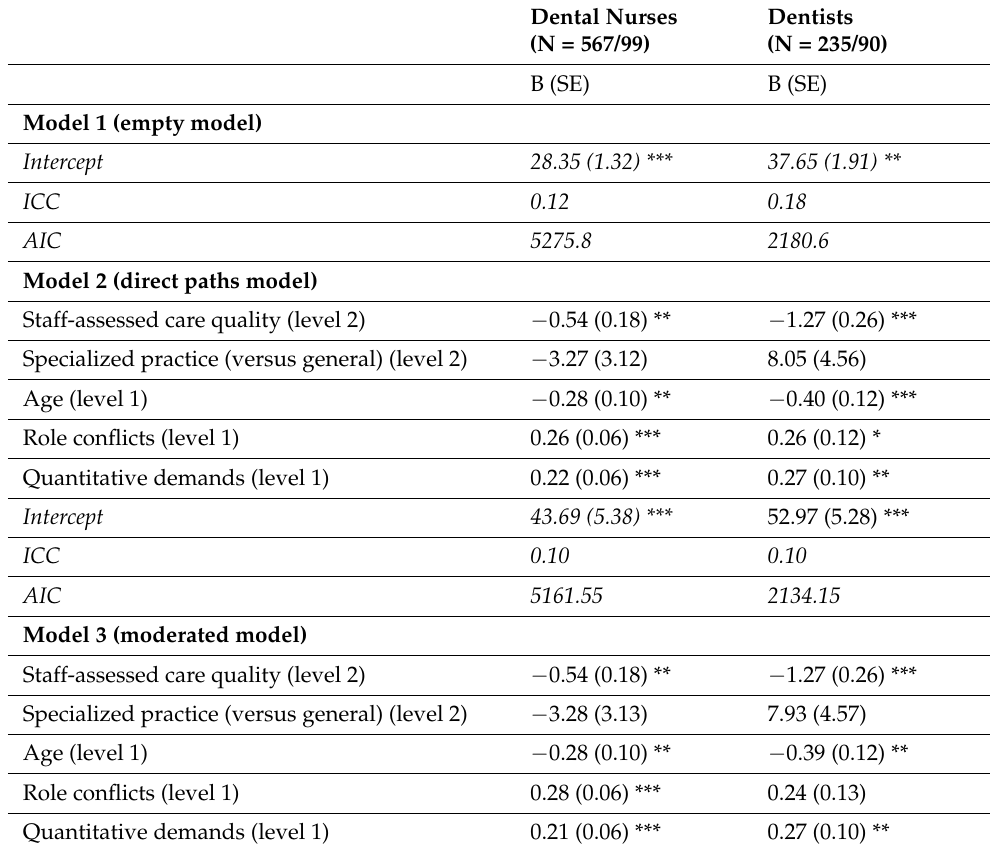
Table 3. Multi-level linear regressions testing the associations of quantitative demands, role conflicts and staff-assessed care quality at the clinic with stress, for dental nurses ( n = 567) and dentists ( n = 235), controlling for age and kind of